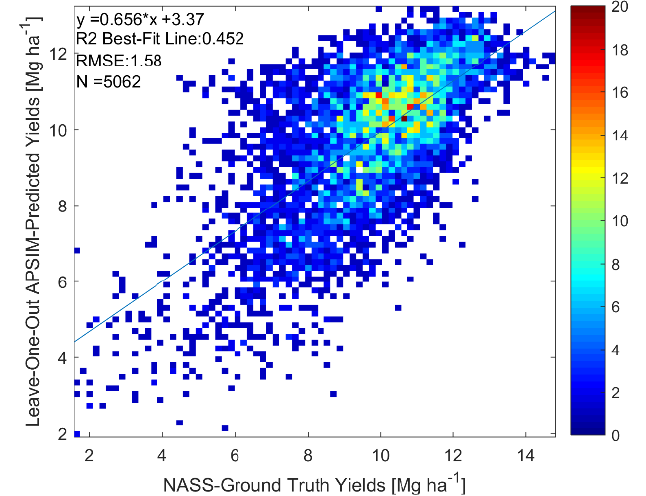
Figure 4. Scatterplot of actual yields versus LOO APSIM-predicted yields for clusterless calibration across entire US Corn Belt. Colorbar represents number of points at a particular pixel in the scatterplot. Table 3. State-level performance of clusterless calibration in predicting phenological stage transition dates as compared to ground-truth USDA NASS crop progress report data over entire US Corn Belt